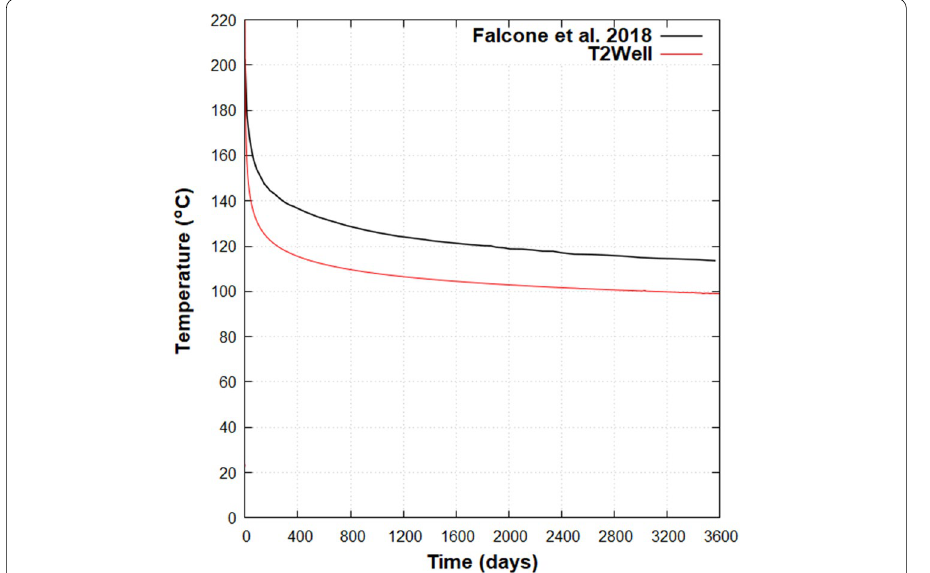
Fig. 4 Numerical results comparison from Falcone et al. (2018) and the T2Well/EOS1